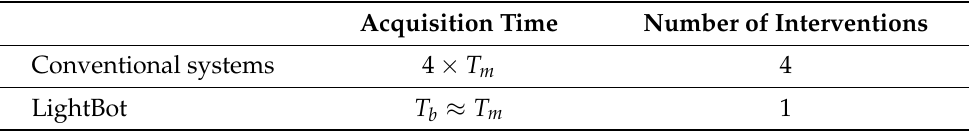
Figure 10. An example of batch acquisition where the system executes acquisition of 4 surfaces one after the other. Table 1. Comparison of number of manual interventions and the acquisition time for acquiring 4 metal print plate samples using conventional system and that with the LightBot